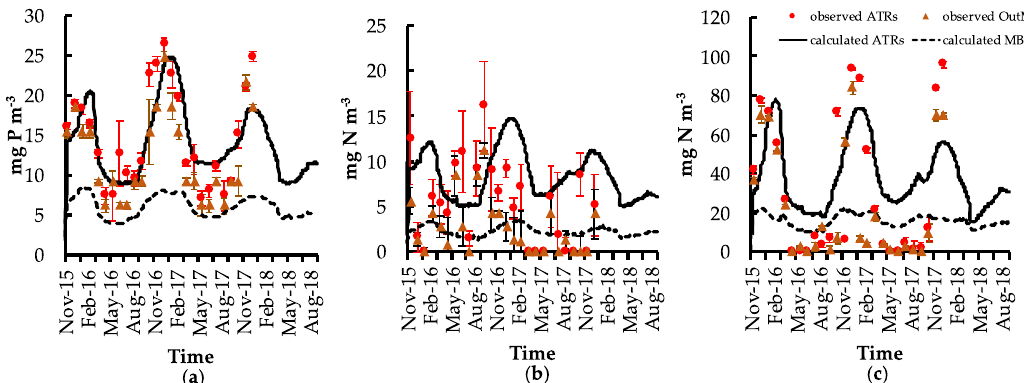
Figure 3. Seasonal changes in ( a ) dissolved inorganic phosphorus (DIP), ( b ) ammonium (NH + ( c ) nitrate (NO − ) concentrations in the artificial timber reef (ATR)-deployed areas and in the Mitsu Bay (MB). The red-filled circles show the observed ATRs, the solid lines show the calculated ATRs, th ebrown-filled triangles show the values observed outside the MB and the black broken lines show the calculated MB values.